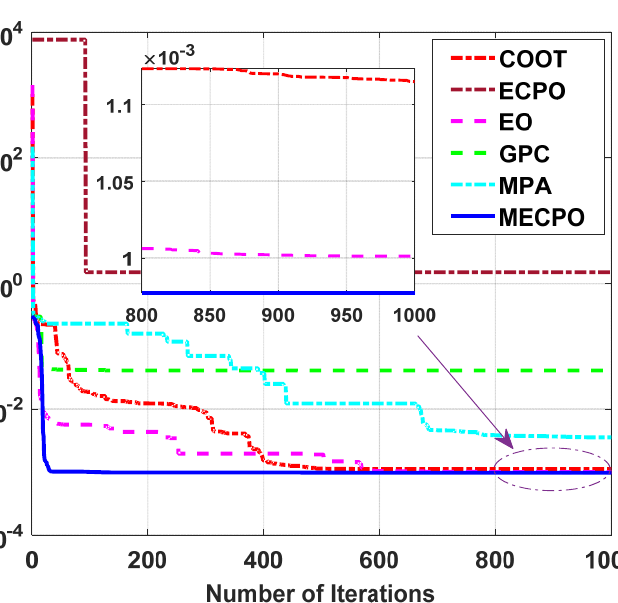
Table 10. Statistical results of the MECPO technique and other recent techniques in the case of the DDM.